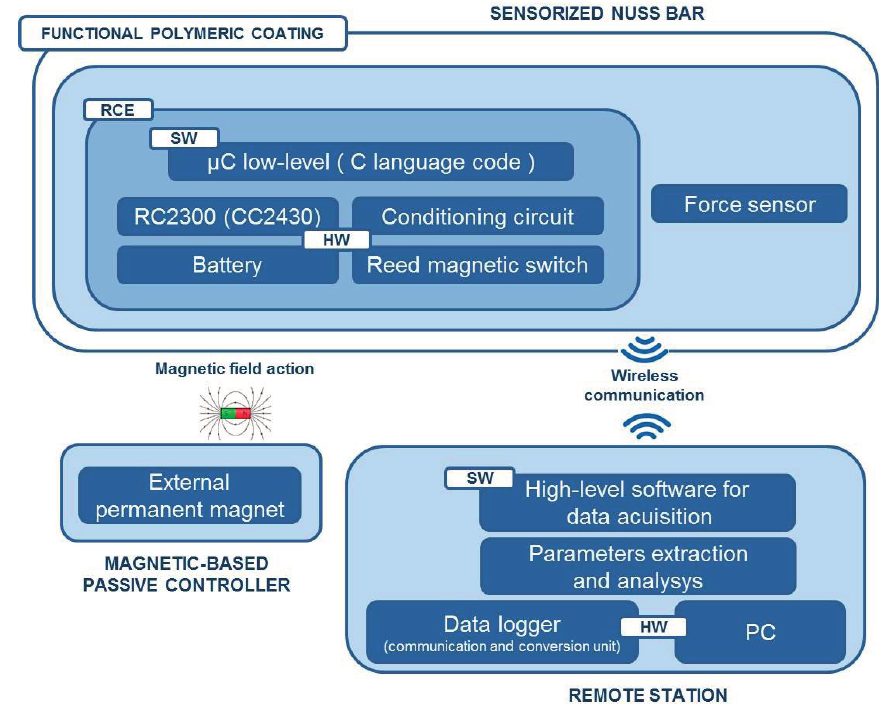
Figure 3. System architecture, components, and